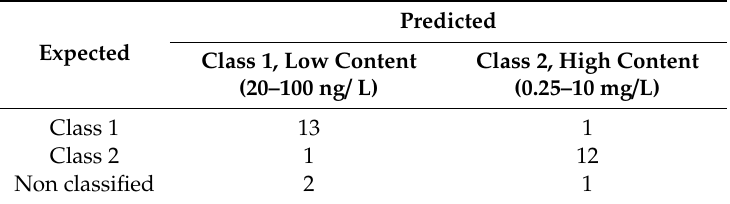
Table 1. Partial least square discriminant analysis (PLS-DA) confusion matrix of tap water samples classification to spiked GE/MIB concentration content.